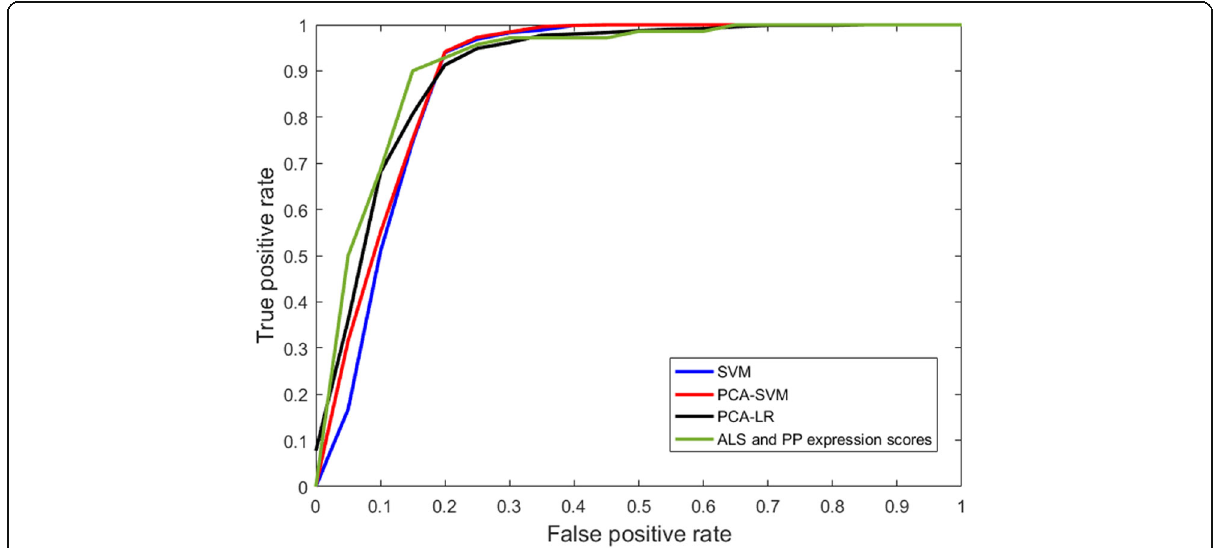
Fig. 2 Average ROC curves for the classification between ALS and PP using SVM, PCA-SVM, and PCA-LR respectively combined with the ROC curve for a SVM classification between ALS and PP based on the ALS- and PP-specific pattern expression scores as determined by PCA-SVM using a healthy control group and projecting individual 18 F-FDG PET scans onto the ALS- and PP-specific metabolic brain